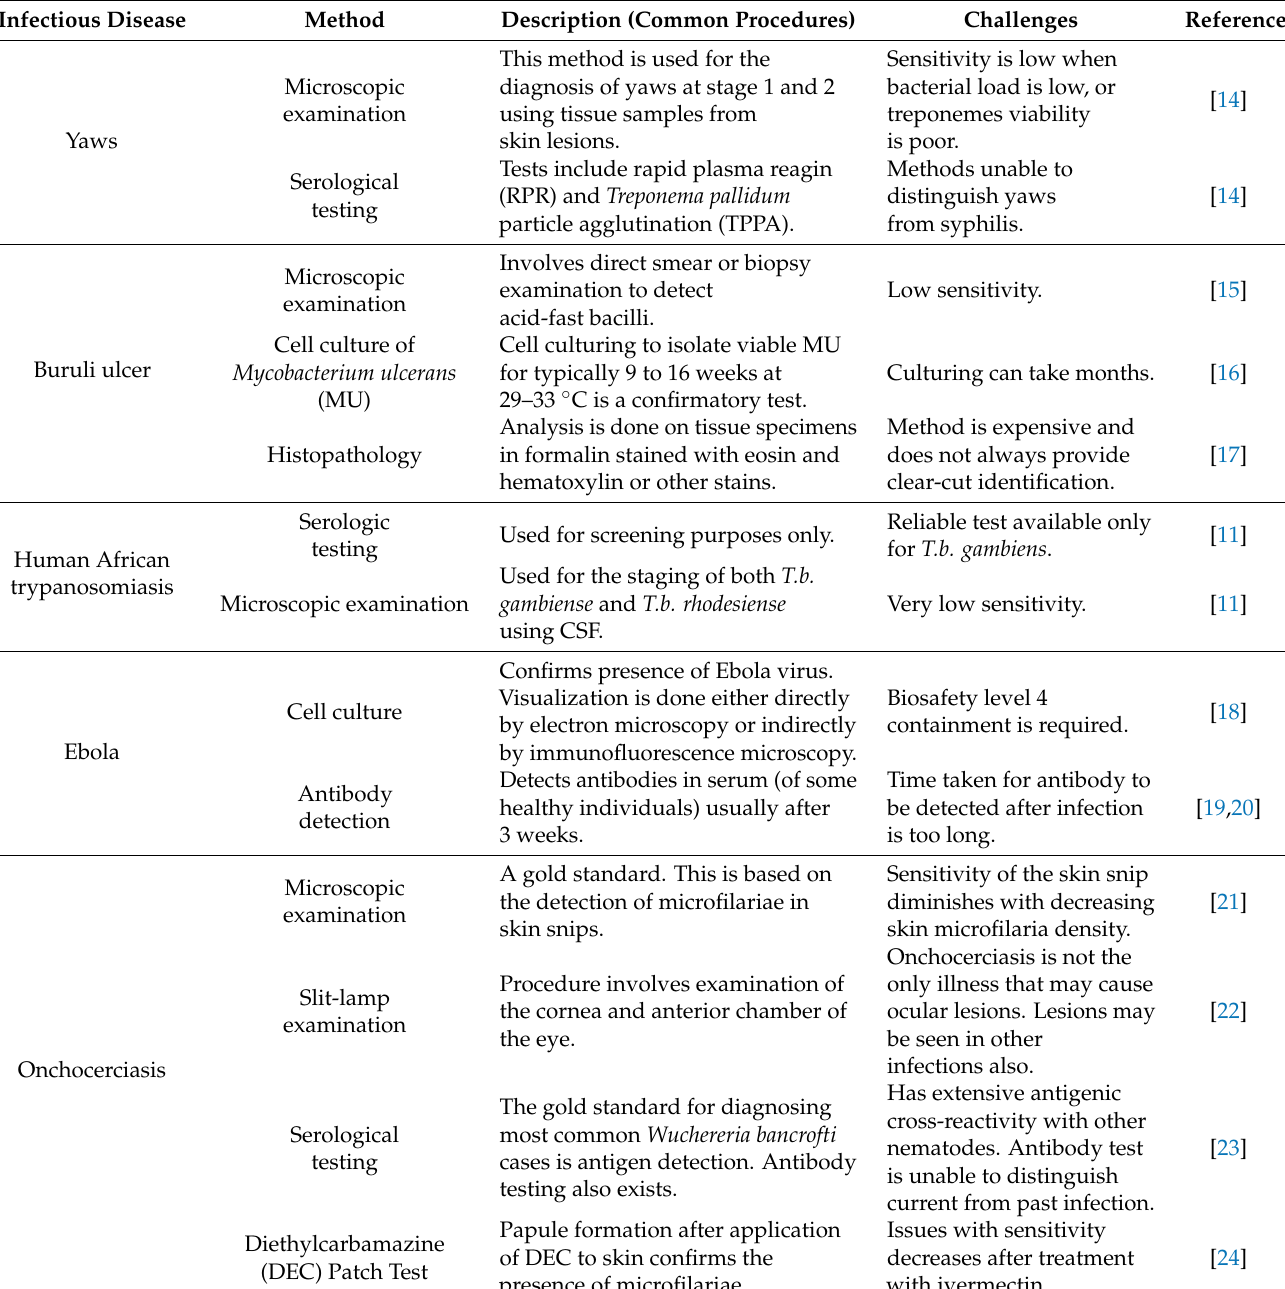
Table 1. Traditional or non-nucleic-acid-based methods of infectious disease